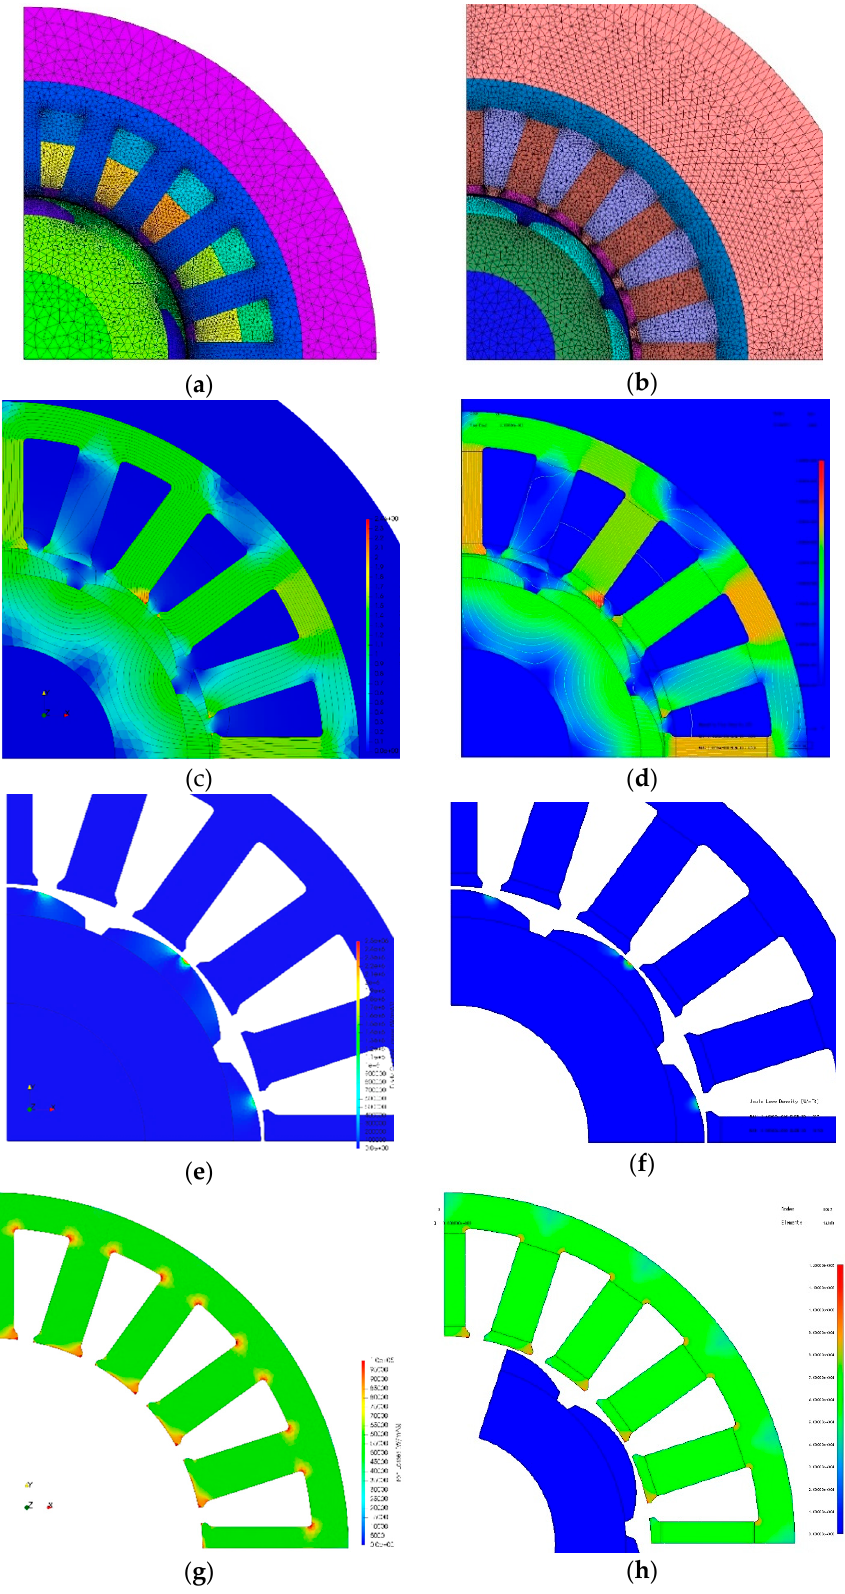
Figure 3. ( a ) Mesh distribution, Elmer; ( b ) mesh distribution, JMAG; ( c ) flux density, Elmer; ( d ) flux density, JMAG; ( e ) Joule loss density, Elmer; ( f ) Joule loss density, JMAG; ( g ) iron loss density, Elmer; ( h ) iron loss density,